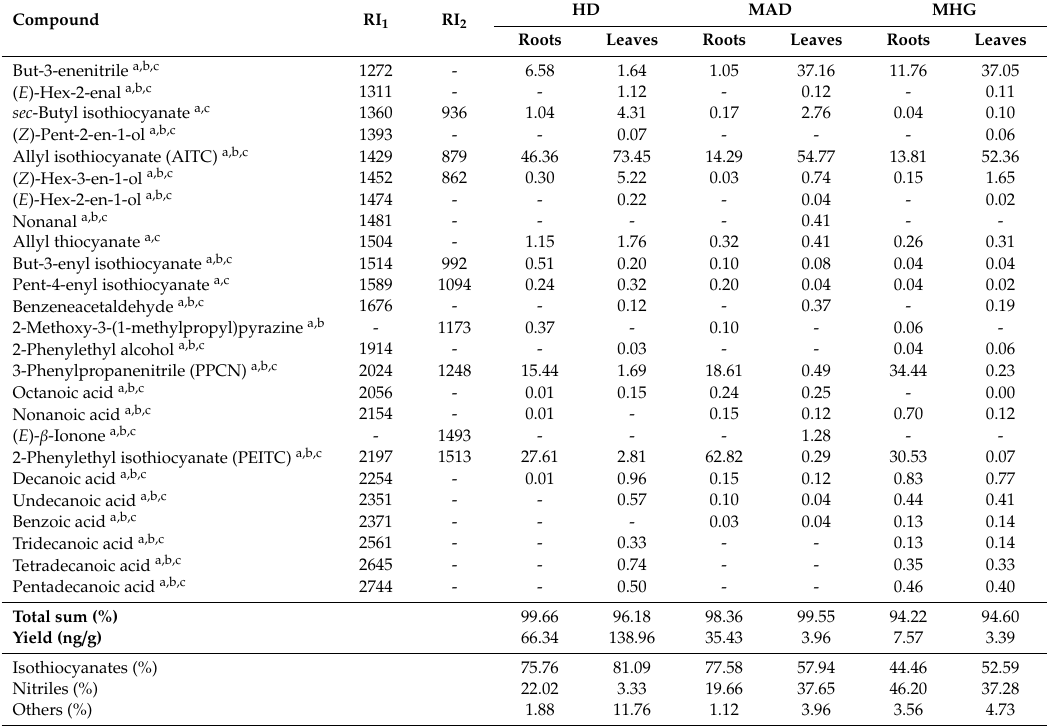
Table 2. Isothiocyanates and other volatiles identified in the roots and the leaves of horseradish by